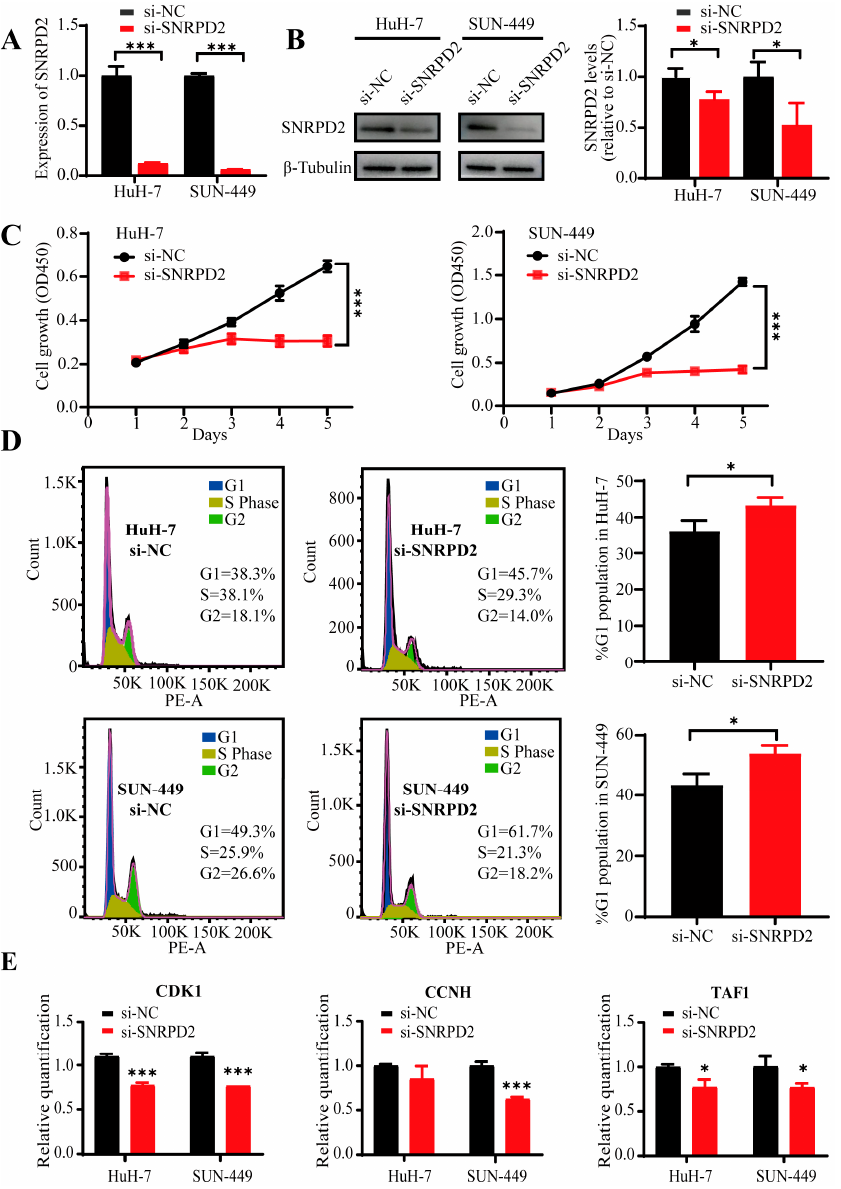
Figure 6. Exploration of the function of SNRPD2 in HCC cell lines. ( A ) SNRPD2 knockdown (KD) efficiency of siRNA detected by qRT-PCR. ( B ) SNRPD2 knockdown efficiency of siRNA detected by Western blot; the statistical result of quantification is shown on the right. ( C ) Proliferation of SNRPD2 KD and NC group detected by CCK8 in HuH-7 and SNU449, respectively. ( D ) Cell cycle of SNRPD2 KD and NC group detected by flow cytometry in HuH-7 and SNU449, respectively. Ratio counts of G1 phase are displayed on the right. ( E ) Detection of transcription cycle related genes after SNRPD2 KD by qRT-PCR in HuH-7 and SNU449, respectively. T-test was used for comparison. Significance level: * p < 0.05, *** p < 0.001.